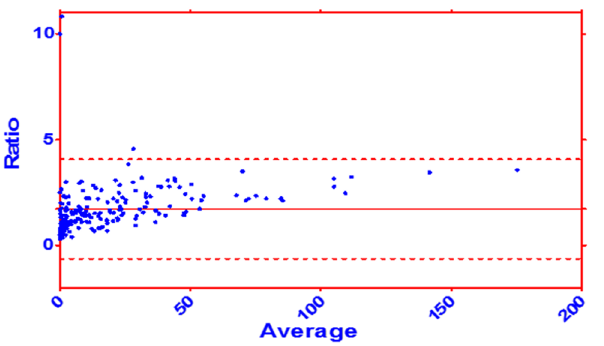
Fig 3. Bland-Altman plot for comparing the od-value with the volumetric acquired lesion volume. Dataset of the day 1 and day 2 combined. Ratio: volumetric volume / od-value. Average: (volumetric volume + od-value) / 2. Mean: 1.722 ± 1.96 SD: -0.626 to 4.071.